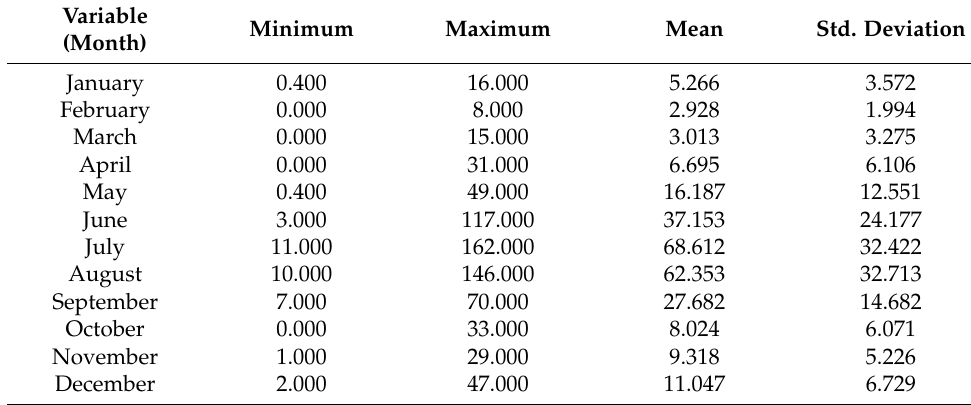
Table 5. Basic statistical characteristics of the Ulan-Ude rainfall data.